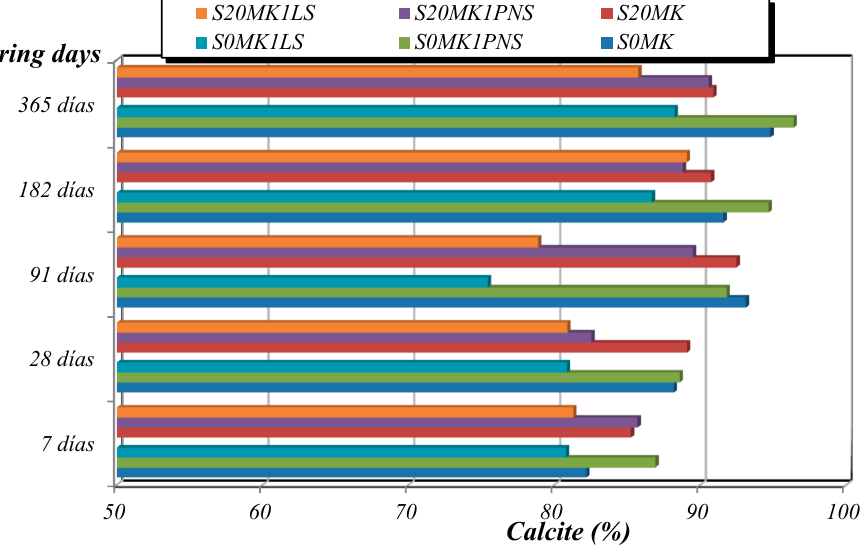
Figure 8. Percentages of CaCO 3 for mortars at different curing times.